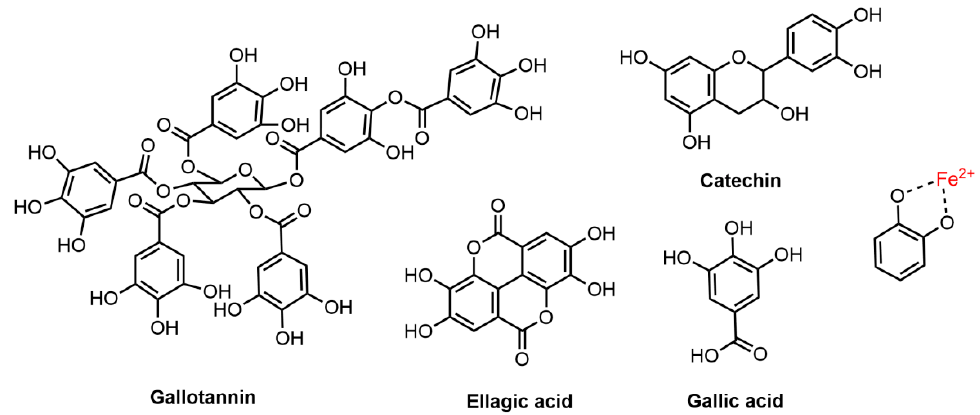
Figure 3. Chemical structures of tannins (gallotannin, ellagic acid, gallic acid and catechin) with a proposed mordanting mechanism when complexed with iron (II) ions.